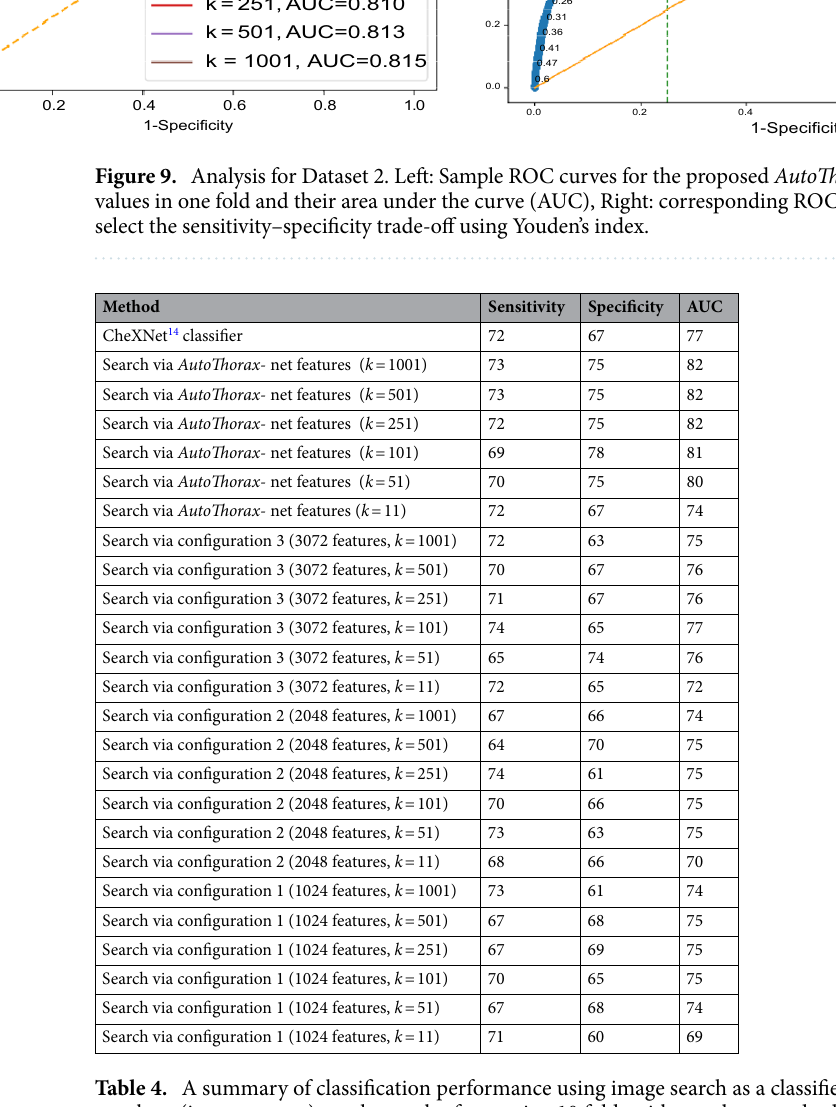
Table 4. A summary of classification performance using image search as a classifier on Dataset 2. The numbers (in percentage) are the result of averaging 10 folds with very low standard deviation (<